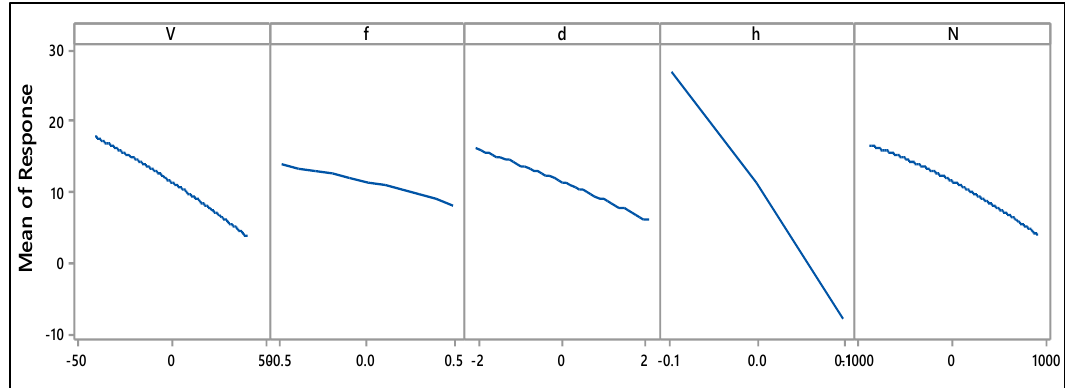
Figure 5: Main effect plot for R a surface